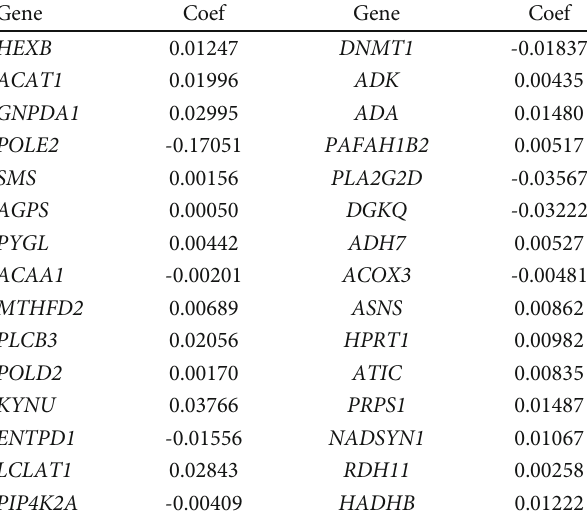
Table 2: Then Lasso-penalized Cox analysis found 30 genes to build the prognostic